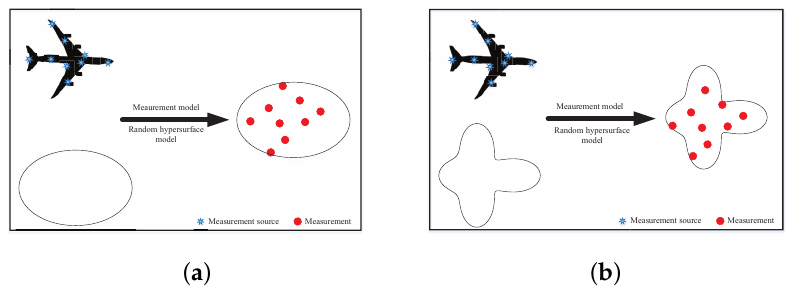
Figure 2. Illustration of approximating an extended object with ellipse/star-convex. ( a ) Ellipse. ( b )